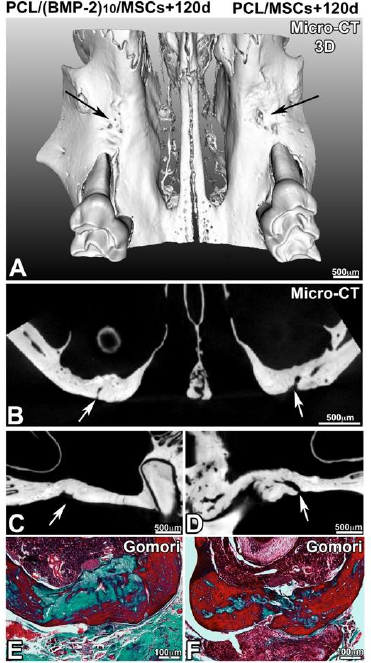
Figure 6. Observation of bone regeneration of the maxillary bone after 120 days of implantation of a PCL membrane functionalized with BMP-2 ( A – C , E ) and non-functionalized ( A , B , D , F ) with hBM-MSCs. A 3D reconstruction ( A ) of frontal ( B ) and sagittal ( C , D ) sections of X-ray microtomography and Gomori trichrome staining ( E , F ).